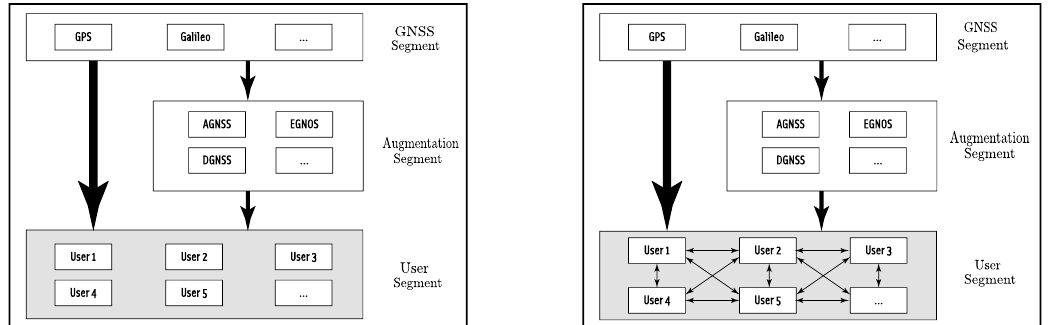
Figure 6. Non-cooperative vs. cooperative GNSS